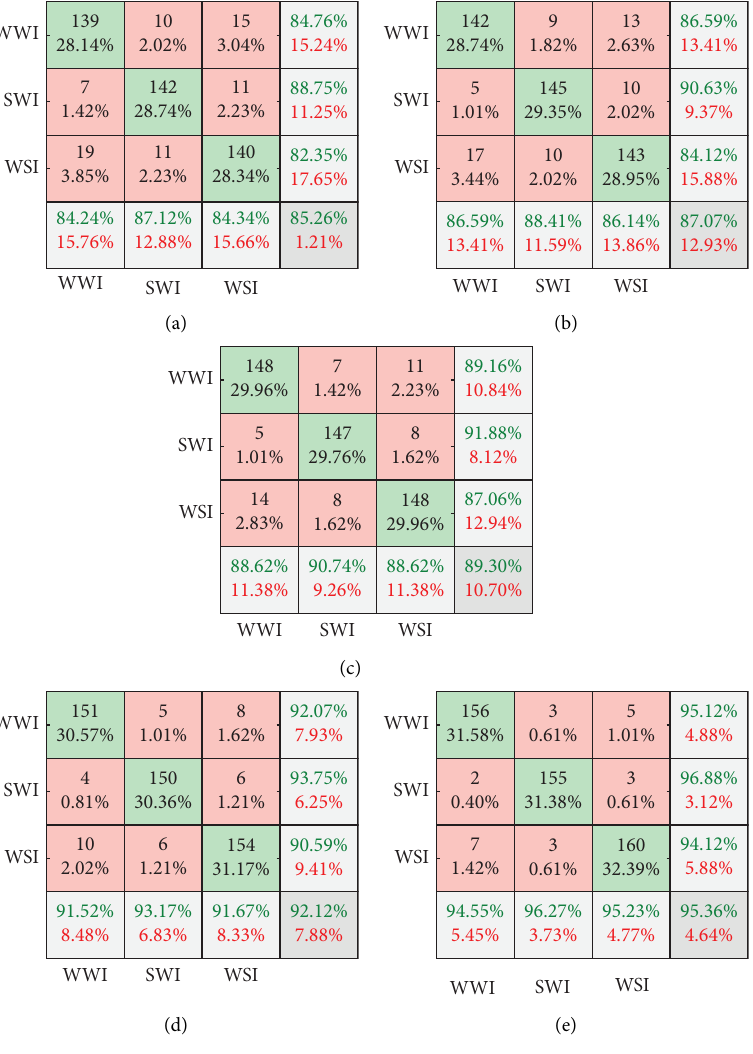
Figure 16: Confusion matrix at 0.5 s before crossing the zebra crossing: the cyan color indicates the number of correct recognitions and their proportion in all samples, and the light red color indicates the number of misrecognitions and their proportion in all samples. Te rightmost column in the fgure is precision, and the bottom column is recall. (a) Confusion matrix of SVM; (b) confusion matrix of LSTM; (c) confusion matrix of AT-Bi-LSTM; (d) confusion matrix of stacking. Table 5: Model evaluation result at 1s before crossing the zebra